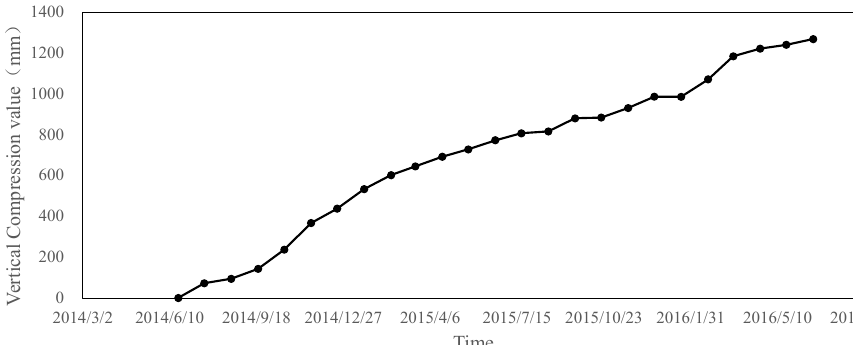
Figure 6. Monitoring arrangement of core wall.